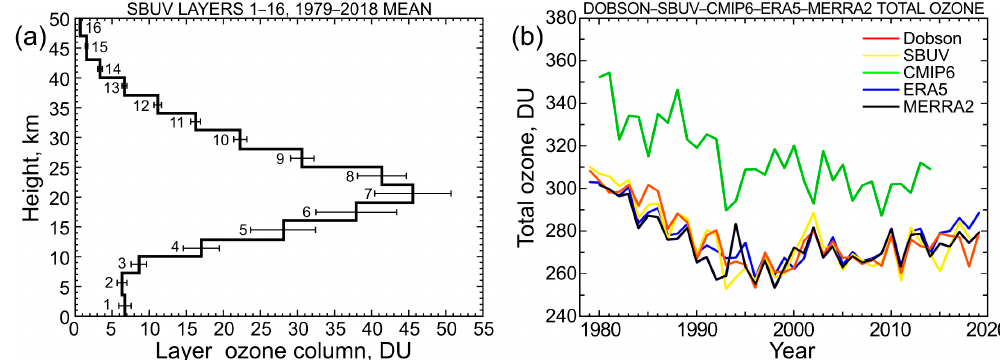
Figure 2. ( a ) The 40-year annual mean climatology (1979–2018) of the SBUV layer ozone column over Faraday / Vernadsky. SBUV layer numbers 1–16 between the pressure levels 1013 and 1 hPa (0–50 km) are indicated. Standard deviations are shown by horizontal bars. Data from [58] are presented. ( b ) Time series of annual mean Dobson spectrophotometer (red), the Solar Backscatter Ultra Violet (SBUV) radiometer (yellow), the Coupled Model Intercomparison Project Phase 6 (CMIP6) (green),